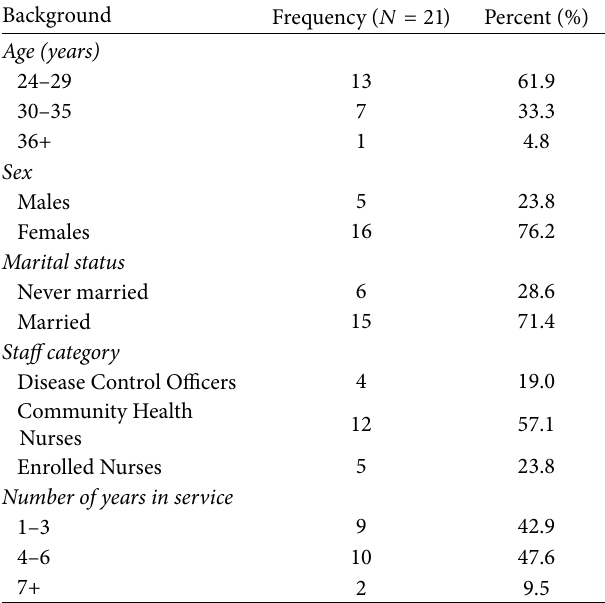
Table 1: Demographic characteristics of